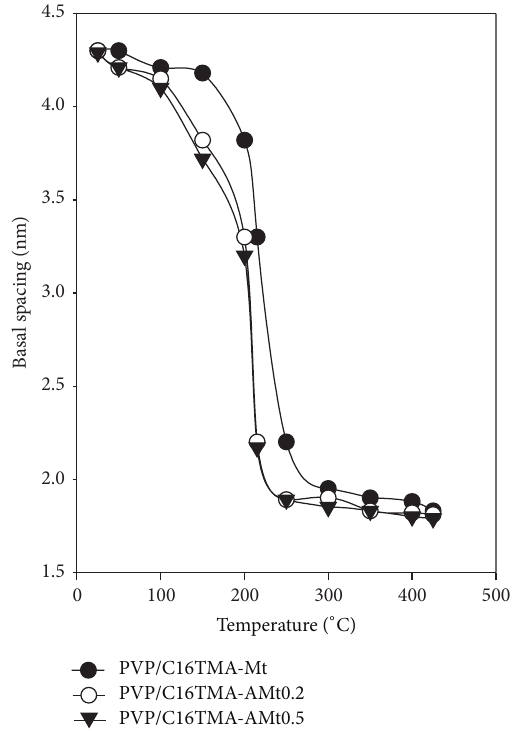
Figure 6: Variation of the basal spacing of the different materials calcined at different